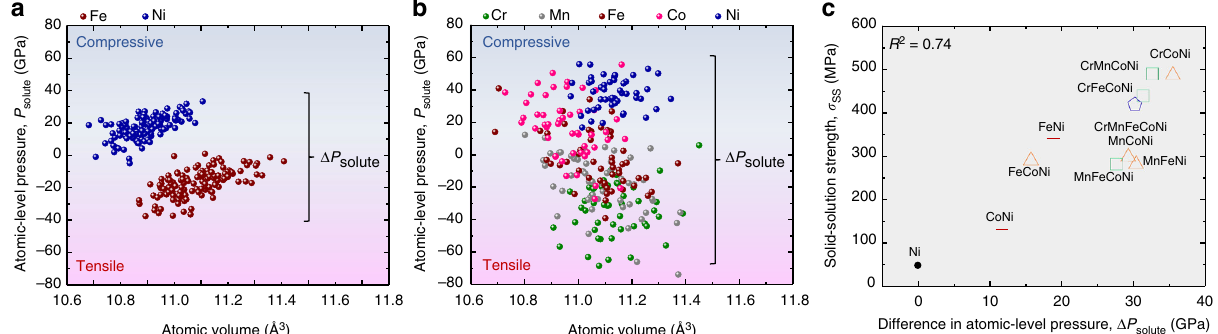
Fig. 2 Description of chemical complexity using the difference in atomic-level pressure in 3d CCAs. Atomic-level pressure versus atomic volume relation in a the FeNi CCA and b the Cantor HEA. A positive value means compressive (repulsive) pressure, and a negative value means tensile (attractive) pressure. versus experimentally measured solid-solution strengths σ SS of c Differences in atomic-level pressure Δ P solute